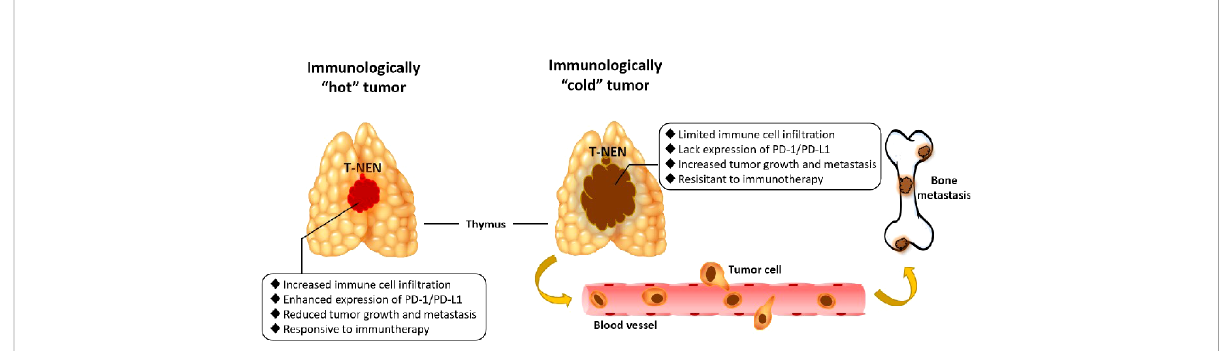
FIGURE 5 Graphical abstract of immunologically ” hot ” and ” cold ” tumors in T-NEN. Immunologically “ hot ” T-NEN with increased immune cell in fi ltration and enhanced expression of PD-1/PD-L1 tended to have restricted tumor size and less metastases, and would be more sensitive to immunotherapy. Immunologically “ cold ” T-NEN with limited immune cell in fi ltration and lacking expression of PD-1/PD-L1 tended to grow more aggressively and develop more metastases, especially to bones, and would be more resistant to